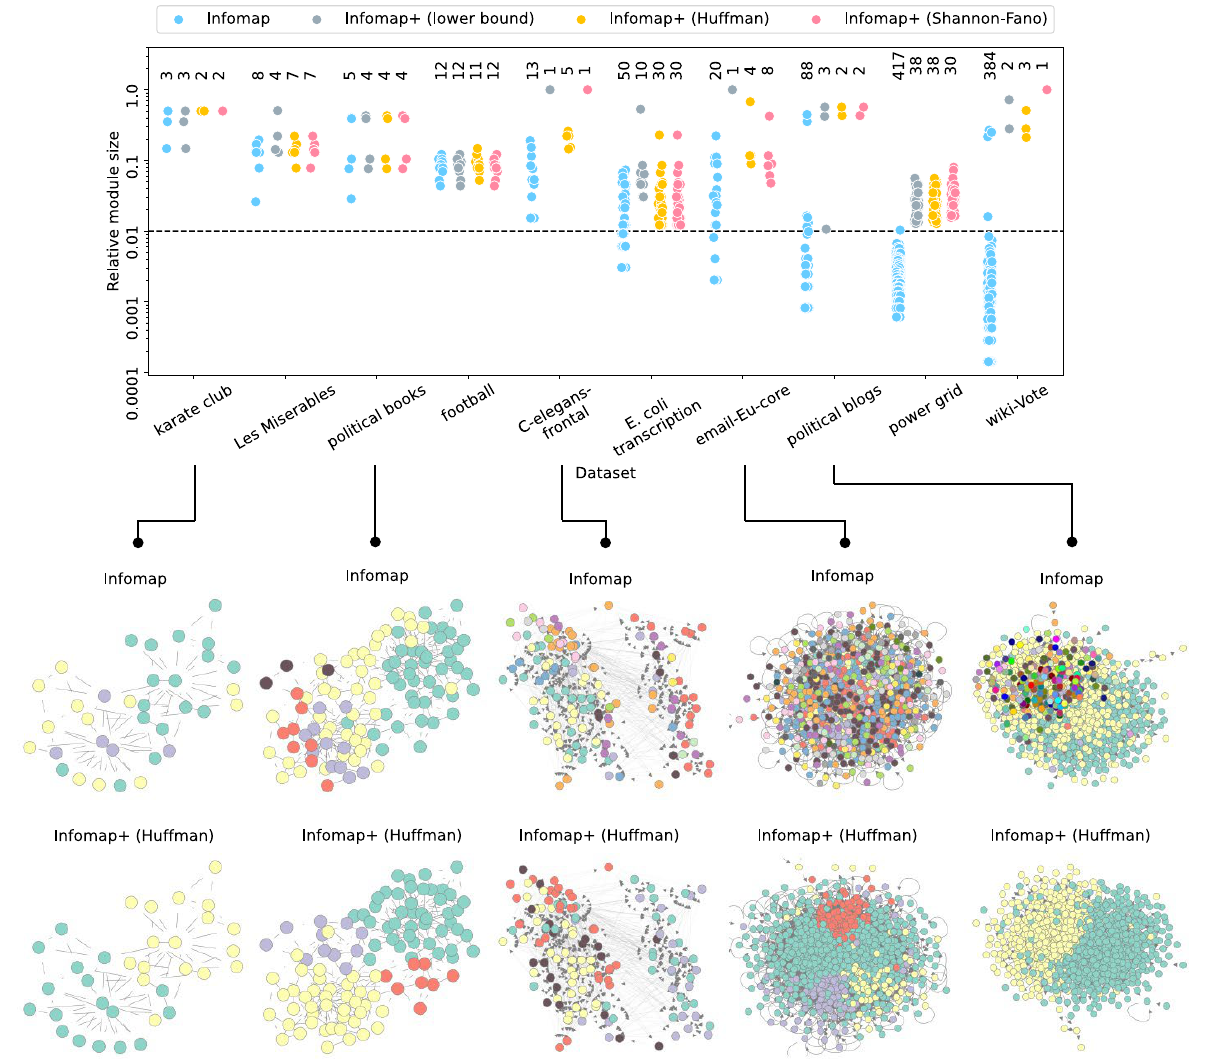
Figure 5. Relative module sizes obtained by Infomap and Infomap+ for real-world networks. The number of identified modules is depicted at the top of each result. The dashed line represents 0.01.